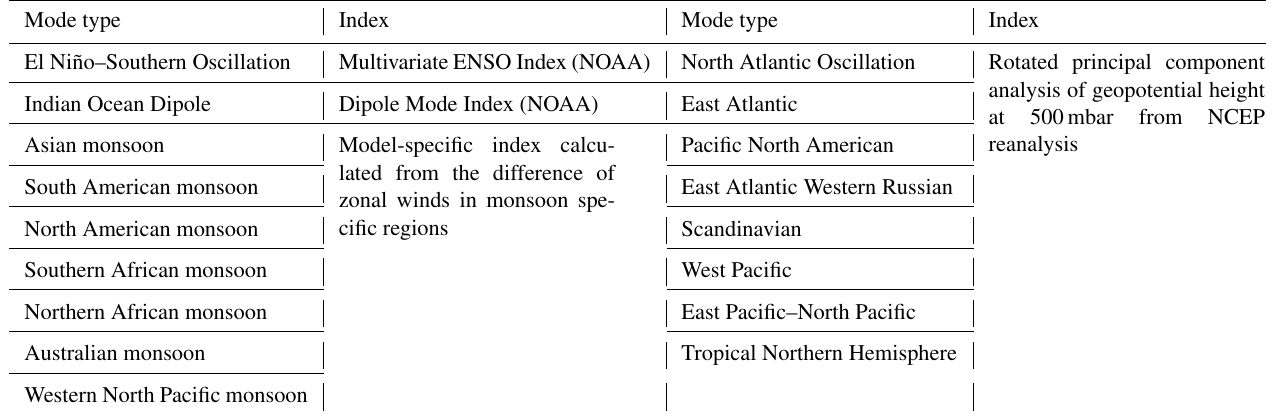
Table 1. Summary of the climate modes and monsoons considered in this work. The index used to characterize the mode, as well as the source of the index, is also indicated. Note: NCEP – National Centers for Environmental Prediction; NOAA –National Oceanic and Atmospheric